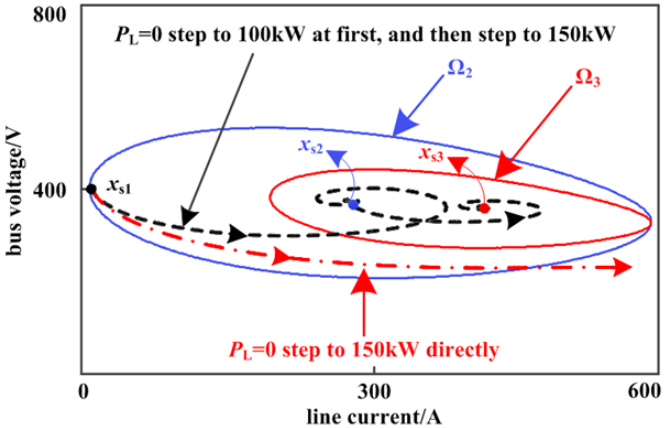
Figure 7. Time domain simulation comparison between reduced-order model and full-order mode.